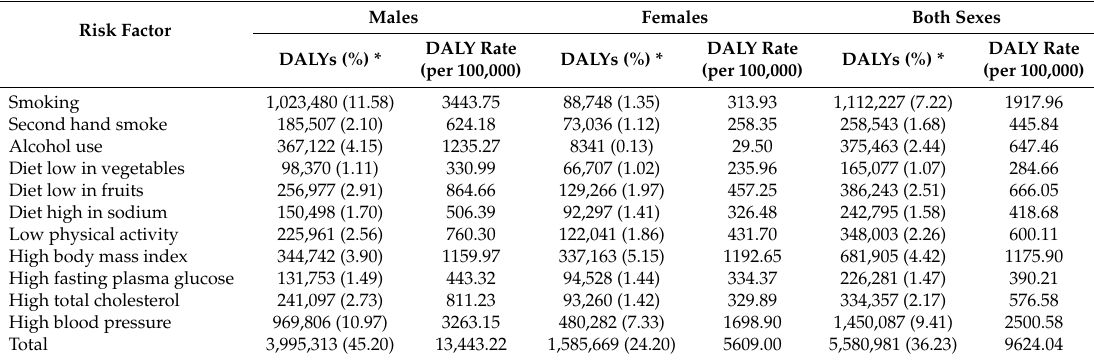
Table 3. Deaths and disability-adjusted life years (DALYs) attributed to 11 risk factors in Hubei Province in 2013.